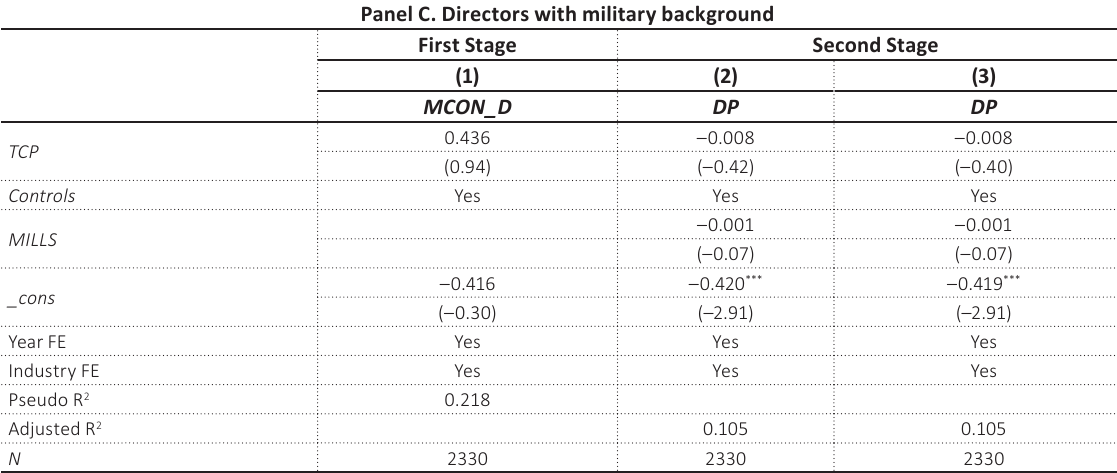
Table 8 (cont.). Heckman’s two-stage